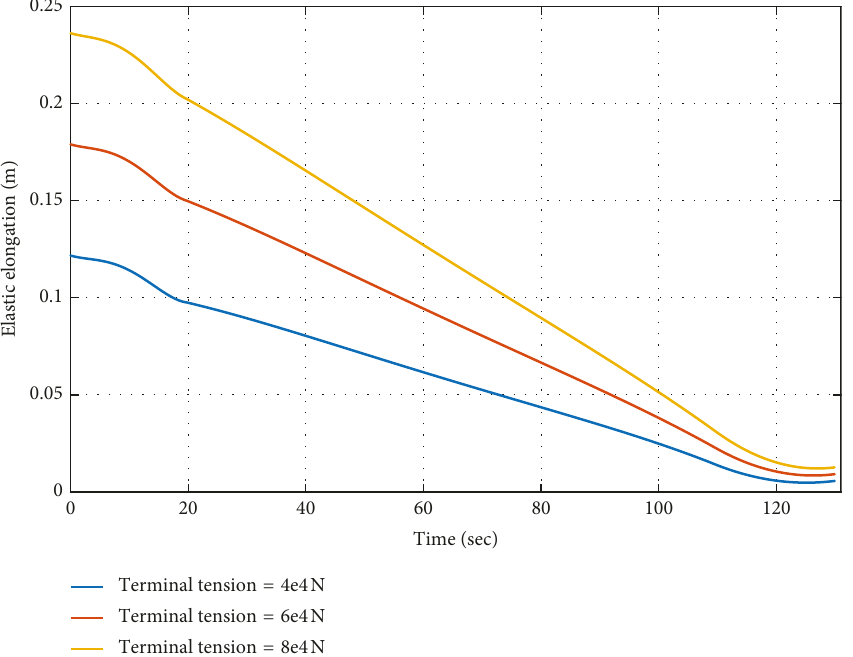
Figure 22: Elastic elongation displacements of the tensioned traction system. (a) Terminal tension tension 6 10 4 N, and (c) terminal tension (cid:31) ×